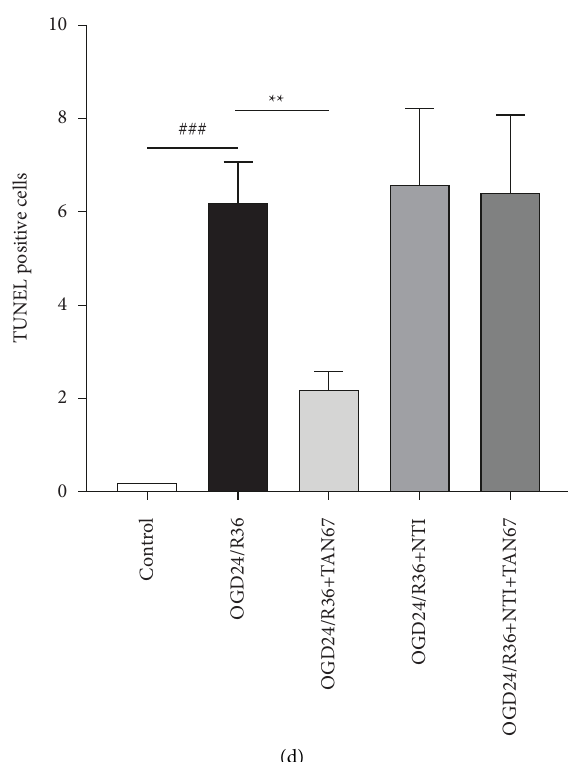
Figure 4: Te DOR agonist TAN-67 reduced the number of necroptotic and apoptotic ARPE19 cells after OGD24/R36. (a) A Calcein-AM/ PI kit was used to distinguish live cells from necroptotic cells. Representative images from left to right: nuclear staining with Hoechst 33258 (blue); calcein-AM staining of live cells (green); PI staining of necroptotic cells (red); merged image. Te white square indicates rep- resentative cells that are magnifed. Scale bar � 100 μ m. (b) Te bar graph represents the number of PI-positive cells in each group ( n � 5 per group). (c) Apoptosis was determined using a TUNEL kit. Representative images from left to right: nuclear staining with Hoechst 33258 (blue); TUNEL of apoptotic cells (green); merged image. Te white square indicates representative cells that are magnifed. Scale bar � 50 μ m. (d) Te bar graph represents the number of TUNEL-positive cells in each group ( n � 5 per group). Data are presented as means ± SEM, and group diferences were analyzed by one-way ANOVA with Fisher’s LSD test. ### P < 0 . 001 compared with the control group; ∗ P < 0 . 05, ∗ ∗ P < 0 . 01 compared with the OGD24/R36